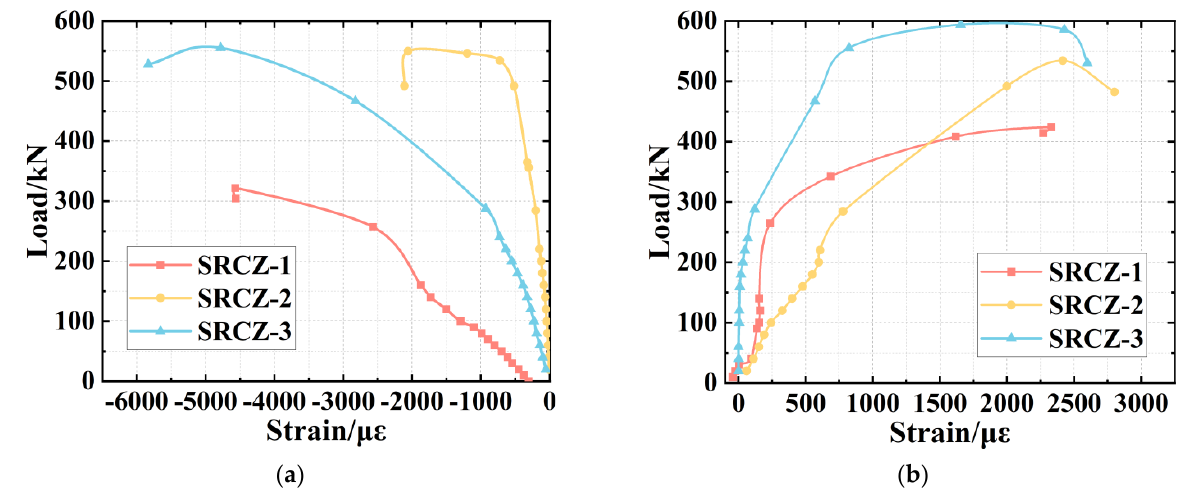
Figure 9. Load – Strain Curve of the H-shape Steel. ( a ) Compressive strain. ( b ) Tensile strain. The experimental results show that the longitudinal reinforcement on the outside of the column bottom has yielded, but the inner reinforcement has not. This situation is due to the bending force that will cause the peak bending positive stress on the outside of the bottom and the small stress on the inside. Regarding the above-mentioned situation, at the outer corner of the column bottom, the steel bar under the longitudinal stress of which the load – strain curve is plotted in Figure 10. The figure shows that the reinforcements achieved the yielding strain, and before the concrete was crushed, the load and strain until the yielding. Furthermore, when the specimens achieved the ultimate load, inaccu- rate measurements occurred in some strain gauges.